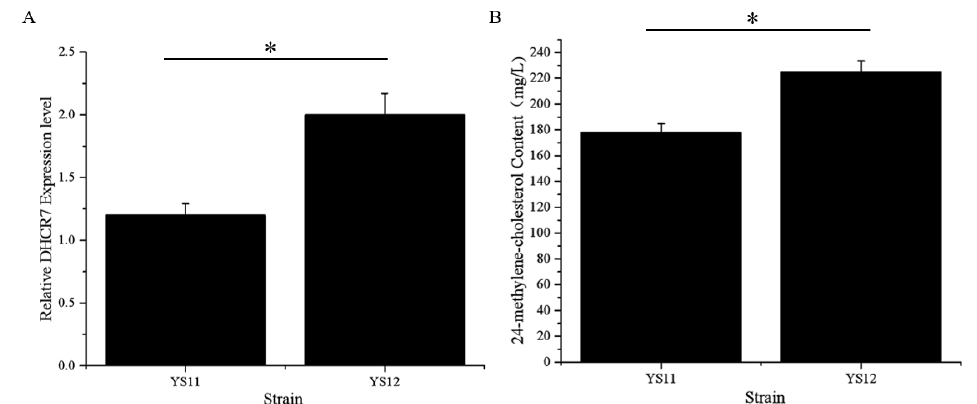
Figure 4 . Identification of fermentation products in recombinant yeast strains via gas chromatog ‐ raphy–mass spectrometry (GC–MS): ( A ) GC–MS patterns of the parent strain YS5 producing er ‐ gosterol, and YS9–11 strains producing the 24 ‐ methylene ‐ cholesterol product. ( B ) Mass chroma ‐ tography of the 24 ‐ methylene ‐ cholesterol product as well as its authentic standard. ( C ) Quantifica ‐ tion of the 24 ‐ methylene ‐ cholesterol produced by the strains YS9, YS10, and YS11. Error bars rep ‐ resent standard deviations ( n = 3). Asterisks indicate significant differences compared to YS9 and YS10; Student’s t ‐ test, * p < 0.05.